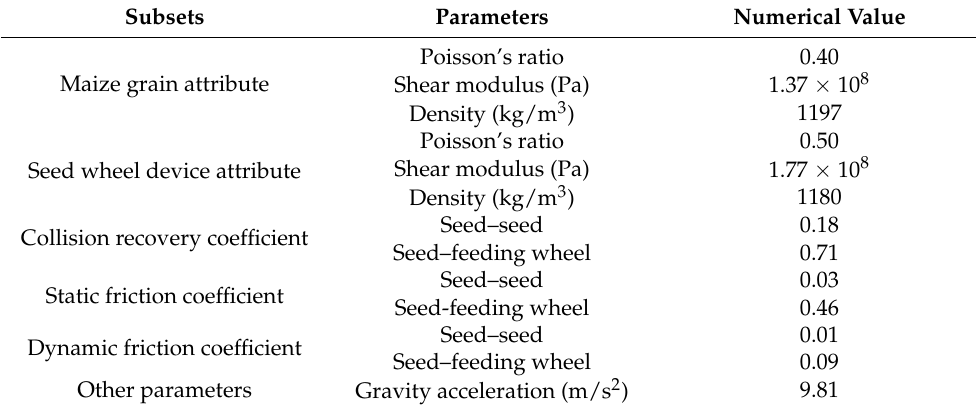
Table 1. Physical and mechanical characteristic parameters required for simulation.